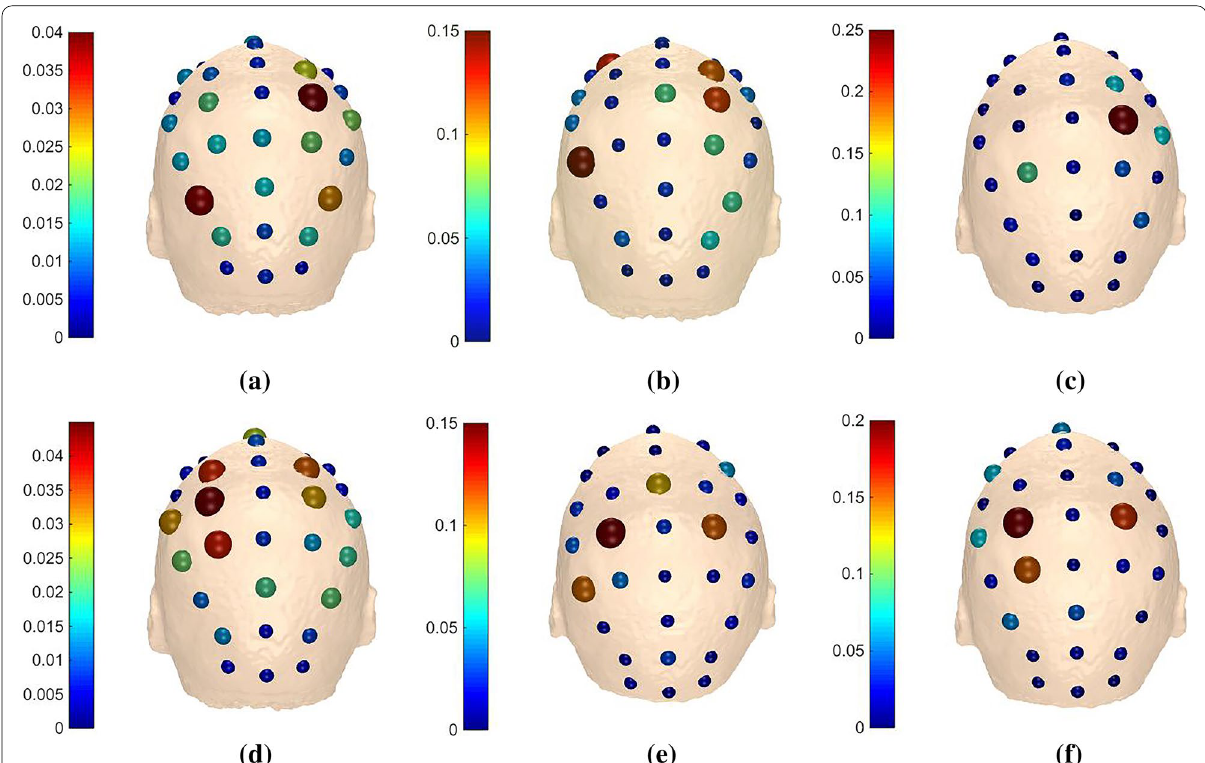
Fig. 10 Outflows of ‘k3b’ in α frequency band a m and f m 3 for ‘RH’ =